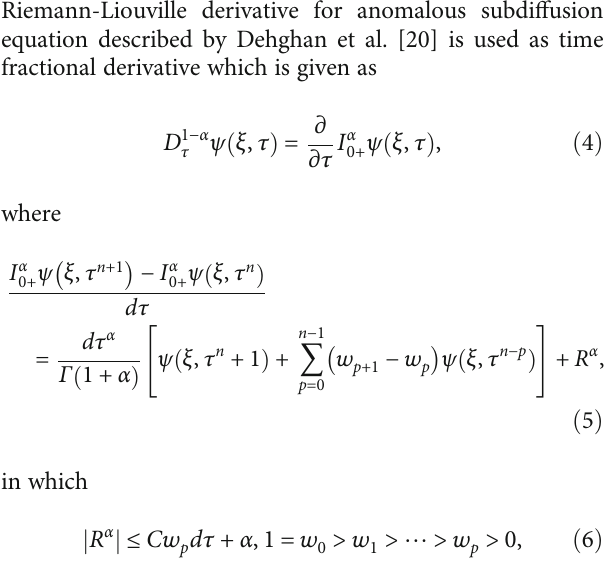
Table 1: Values of hybrid function H